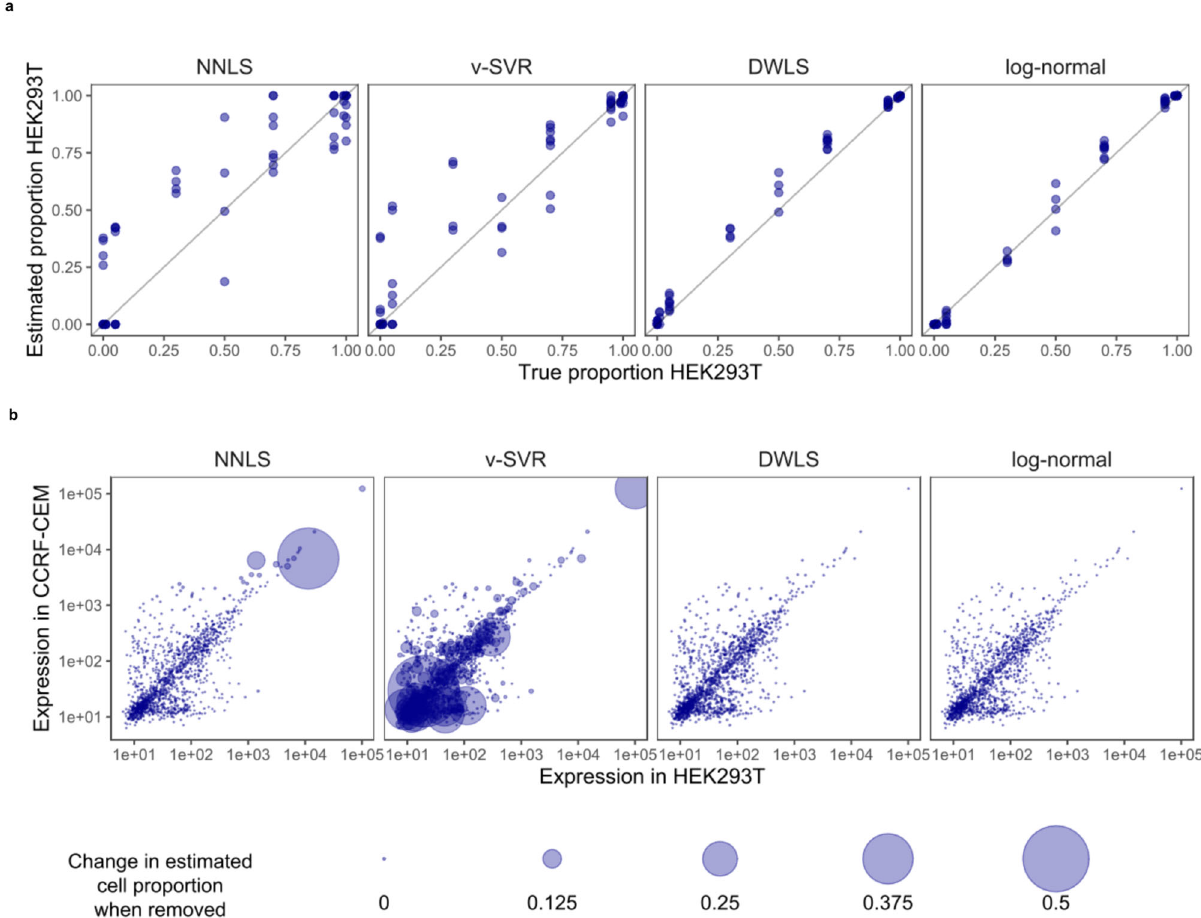
Fig. 2 Comparison of deconvolution algorithms in mixtures of two cell lines. The cell lines HEK293T and CCRF-CEM were mixed in varying proportions and pro fi led with the GeoMx platform. a True mixing proportions plotted against estimates from four deconvolution algorithms: non-negative least squares (NNLS), v-support vector regression (v-SVR), Dampened Weighted Least Squares regression (DWLS), and log-normal regression. b In fl uence of each gene on the deconvolution result from a single cell pellet with a 50 – 50 mix. Point size shows the change in estimated mixing proportion when each gene is removed. Source data are provided as a Source Data fi